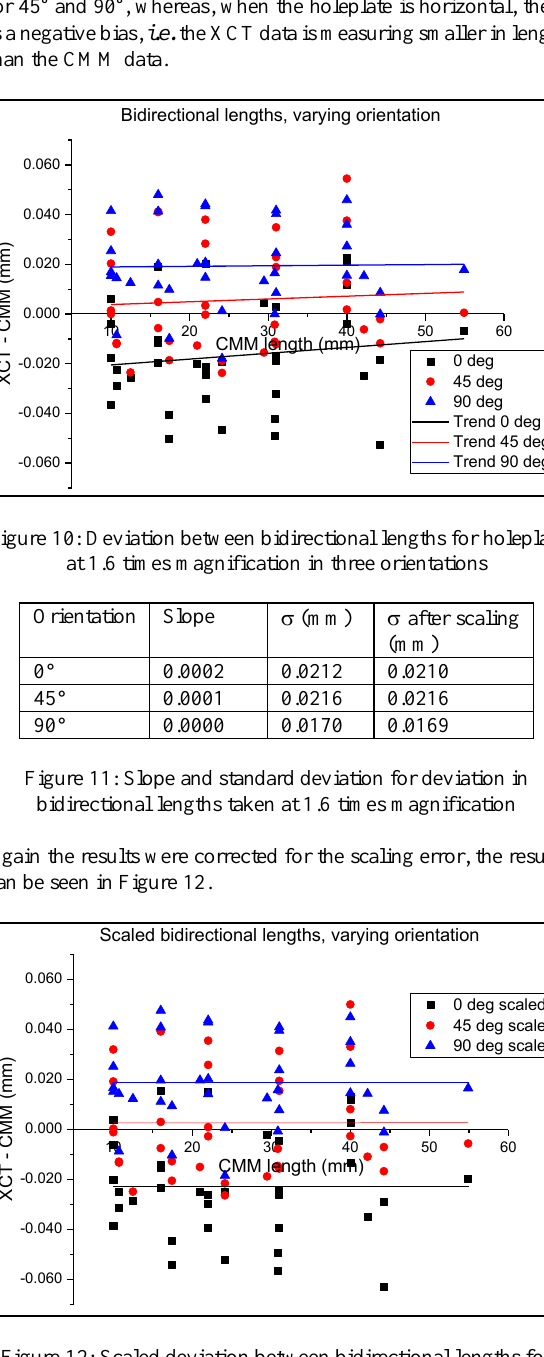
Figure 12: Scaled deviation between bidirectional lengths for holeplate at 1.6 times magnification in three orientations